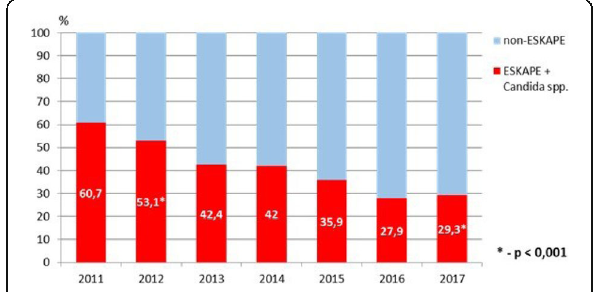
Fig. 2 (abstract 001406). The changes in the share of ESKAPE- bacteremia and candidaemia in the